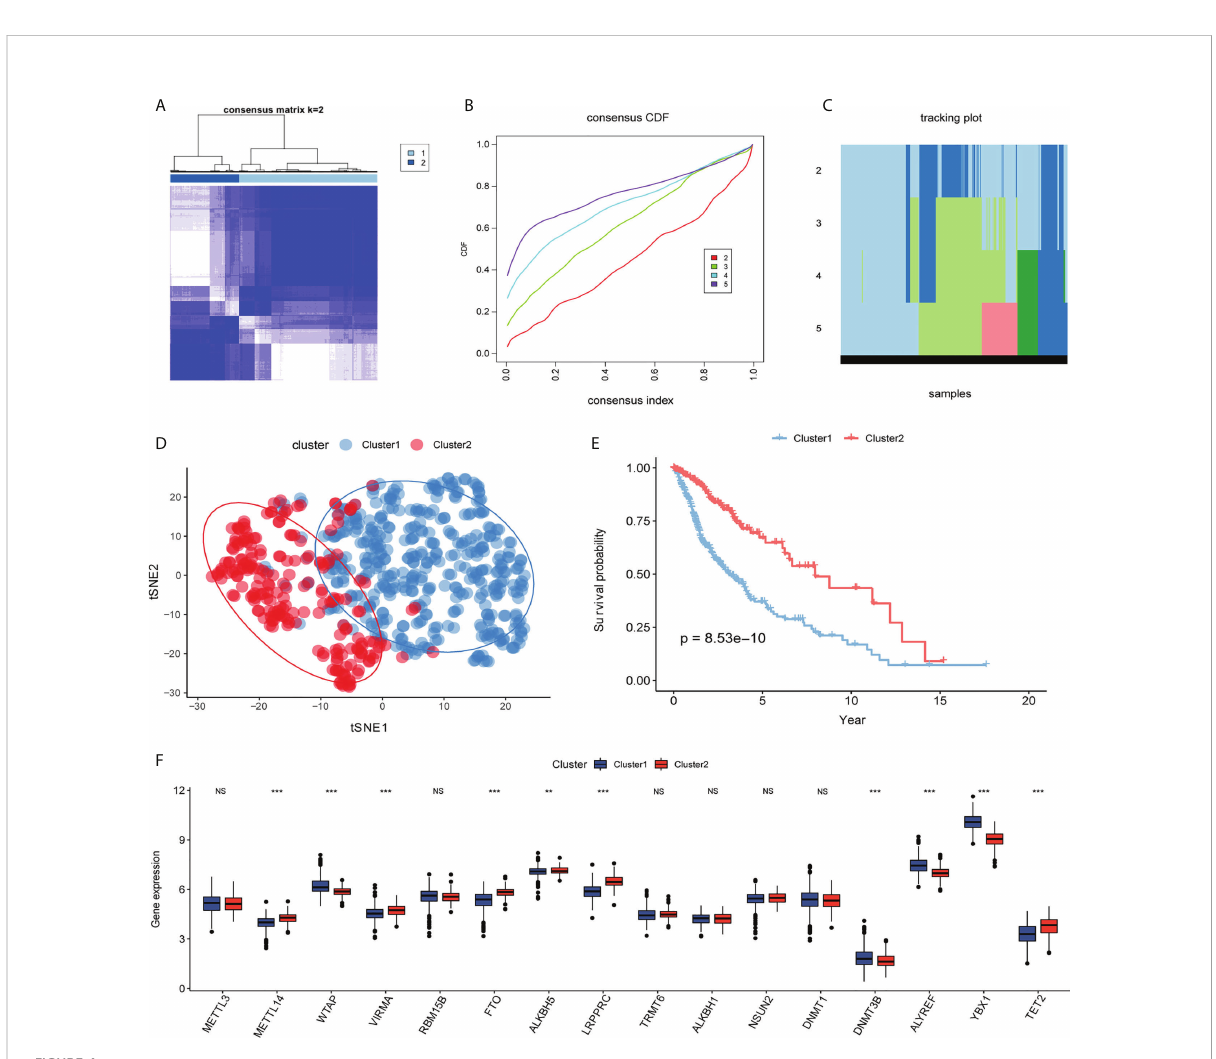
FIGURE 4 Molecular typing. (A – C) Consistent clustering of differentially expressed m 6 A/m 5 C/m 1 A-related genes (k=2 – 5). (D) According to t-distributed stochastic neighbor embedding (t-SNE) analysis, there is a good distinction between different cluster samples, with blue representing cluster 1 and red representing cluster2. (E) Kaplan – Meier curve between different clusters, blue represents cluster1, and red represents cluster2. (F) The box plot shows the expression levels of genes related to m 6 A/m 5 C/m 1 A among different clusters, with blue representing cluster1 and red representing cluster2. (NS:no signi fi cant) (**P < 0.01, ***P <